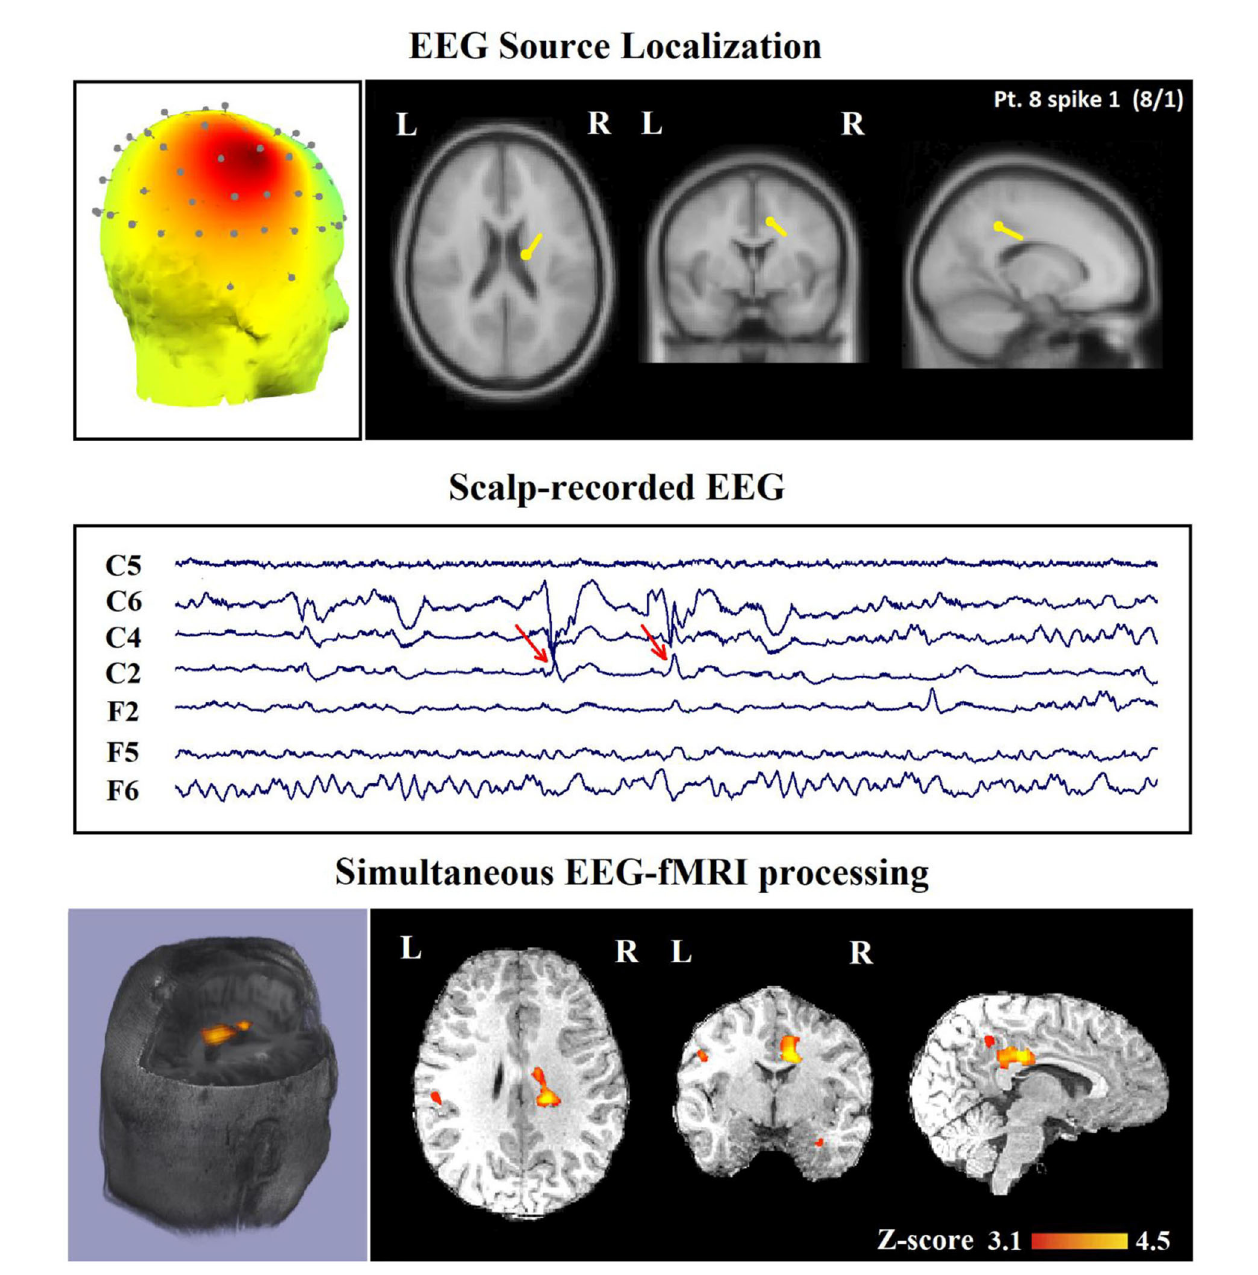
FIGURE 7 | (Patient 8—spike 1) marked events are C4–C6 spikes (referential montage), and TCCC-related BOLD response shows a focal activation in the right head. This response is considered concordant with the spike field and contributory, because it shows the involvement of a deep brain structure, in the epileptic focus, which is not visible on the scalp EEG, based on anatomo-electroclinical correlations. The focus was identified in the cerebral medulla (with matter). Top, the component identified on scalp EEG located in the right temporal lobe and the dipole localization of the identified generator in deep brain structures. The active area is marked with a yellow-red color. Middle, scalp recorded EEG. Bottom, Localization of the generator applying simultaneous analysis of EEG-fMRI.